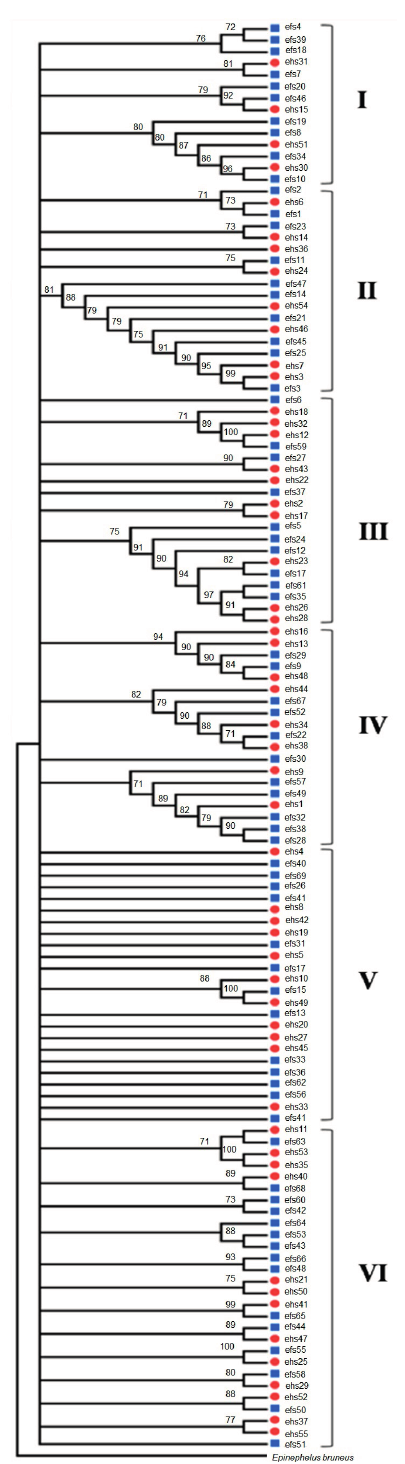
Figure 1. NJ evolutionary of 16S gene. The square shapes represent E. fuscoguttatus , and the round shapes represent E. hexagonatus . Numbers represent grouper cluster. Branches corresponding to partitions reproduced in less than 70% of the bootstrap replicates are collapsed. I–VI represent six unique of